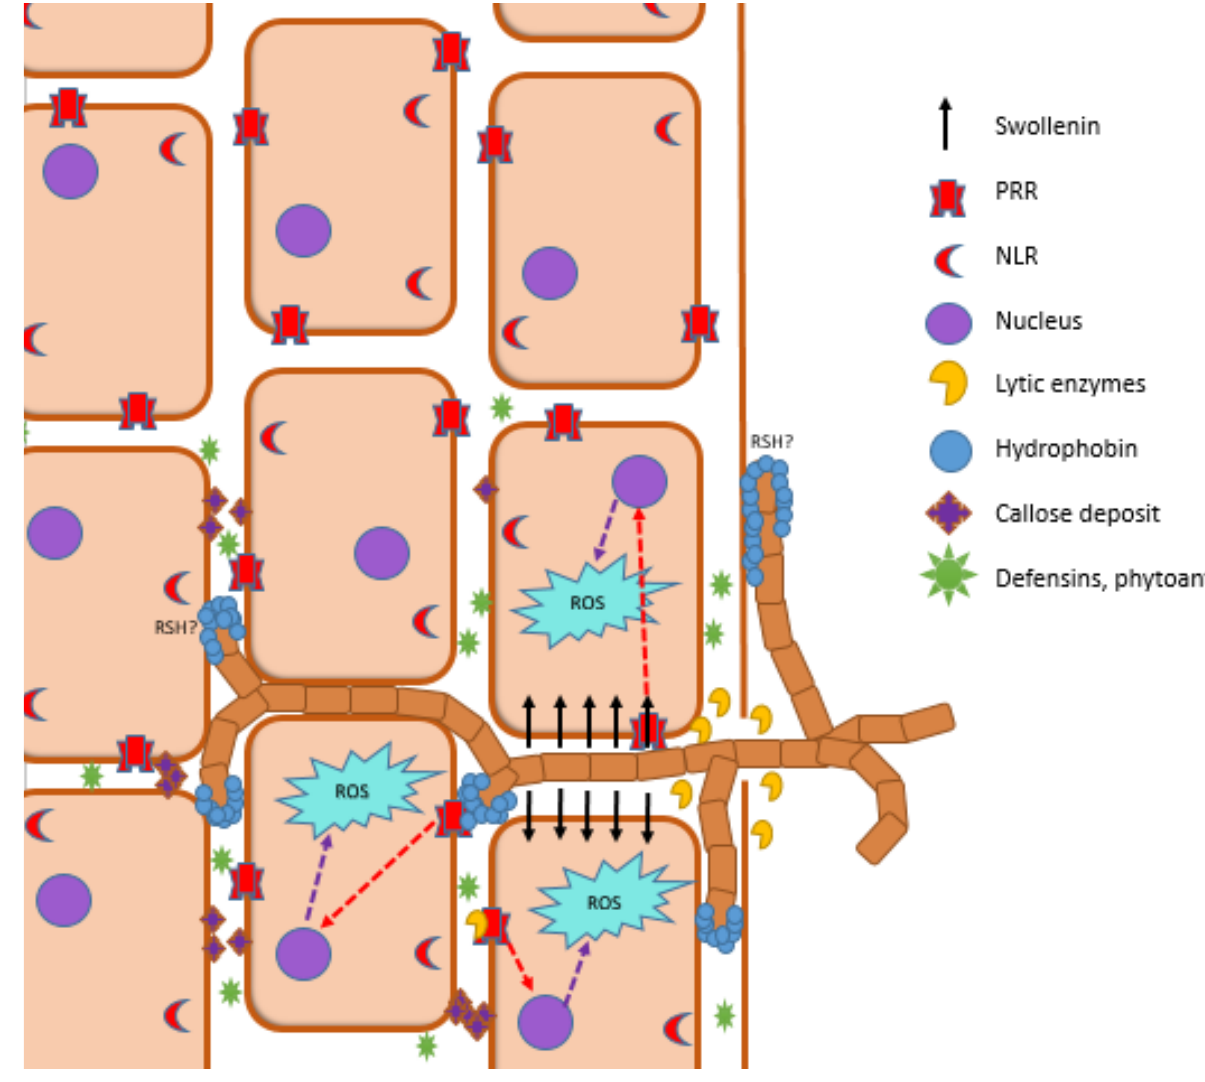
Figure 2. Colonization of root by a fungus belonging to Trichoderma . Adhesion and protection of hyphae are mediated by the layer of hydrophobins, whereas lytic enzymes enable penetration of the epidermis. Swollenins facilitate penetration of apoplast through an expansion-like effect on plant cell walls. Recognition of Trichoderma -derived MAMP molecules (swollenins, hydrophobins, cellulolytic enzymes, and chitin) triggers plant responses to infection, i.e., synthesis of antimicrobial compounds (defensins and phytoanticipins), synthesis of the callose wall in order to physically inhibit further penetration, and overproduction of ROS and possibly also alarmones. See text for more details. Sucrose plays important role in plant colonization by Trichoderma . As demonstrated by Mac í as-Rodr í guez et al. [468], the concentration of carbohydrates, mainly arabinose, xylose, myo-inositol, fructose, and glucose in root exudates of L. esculentum is higher before colonization by T. atrioviride . Colonization of the root by T. atrioviride changed the exudation pattern and sucrose became a major component of exudates. Root-derived sucrose specifically enables better growth of fungi belonging to Trichoderma, since AMF fungi prefer glucose and fructose as a source of carbon. Analysis of the proteome of